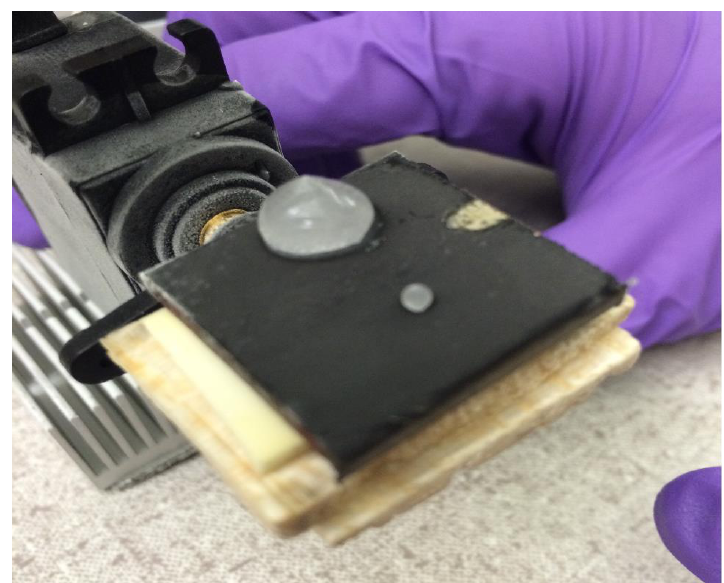
Figure 4. A photograph of “ball-up” freezing on an icephobic carbon soot coated aluminum substrate with surface temperature of ~− 10 °C, exposed to room temperature conditions ( T ~22 °C; RH — 50%).